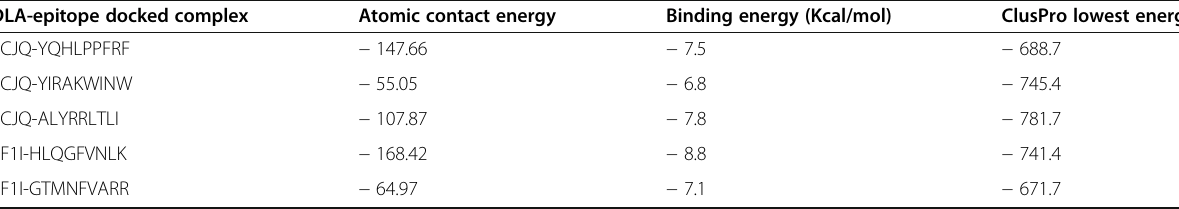
Table 3 DLA-epitope complex docking analysis: ACE values and binding energy values for best possible complexes DLA-epitope docked complex Atomic contact energy Binding energy (Kcal/mol) ClusPro lowest